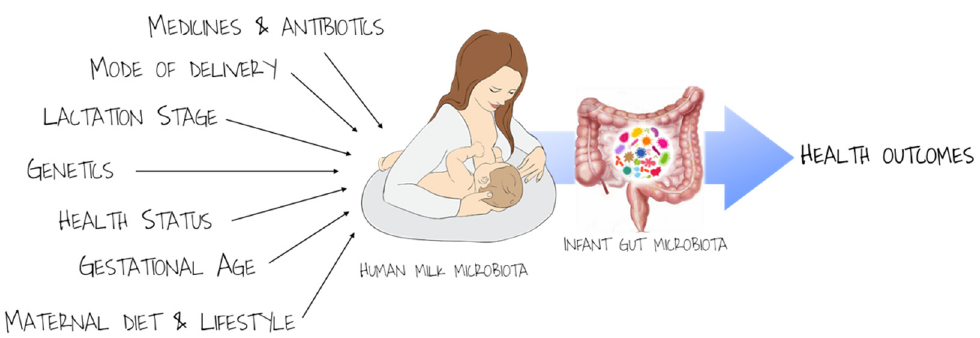
Figure 1. Modulation of infant gut microbiota via mother gut and human milk microbiota.